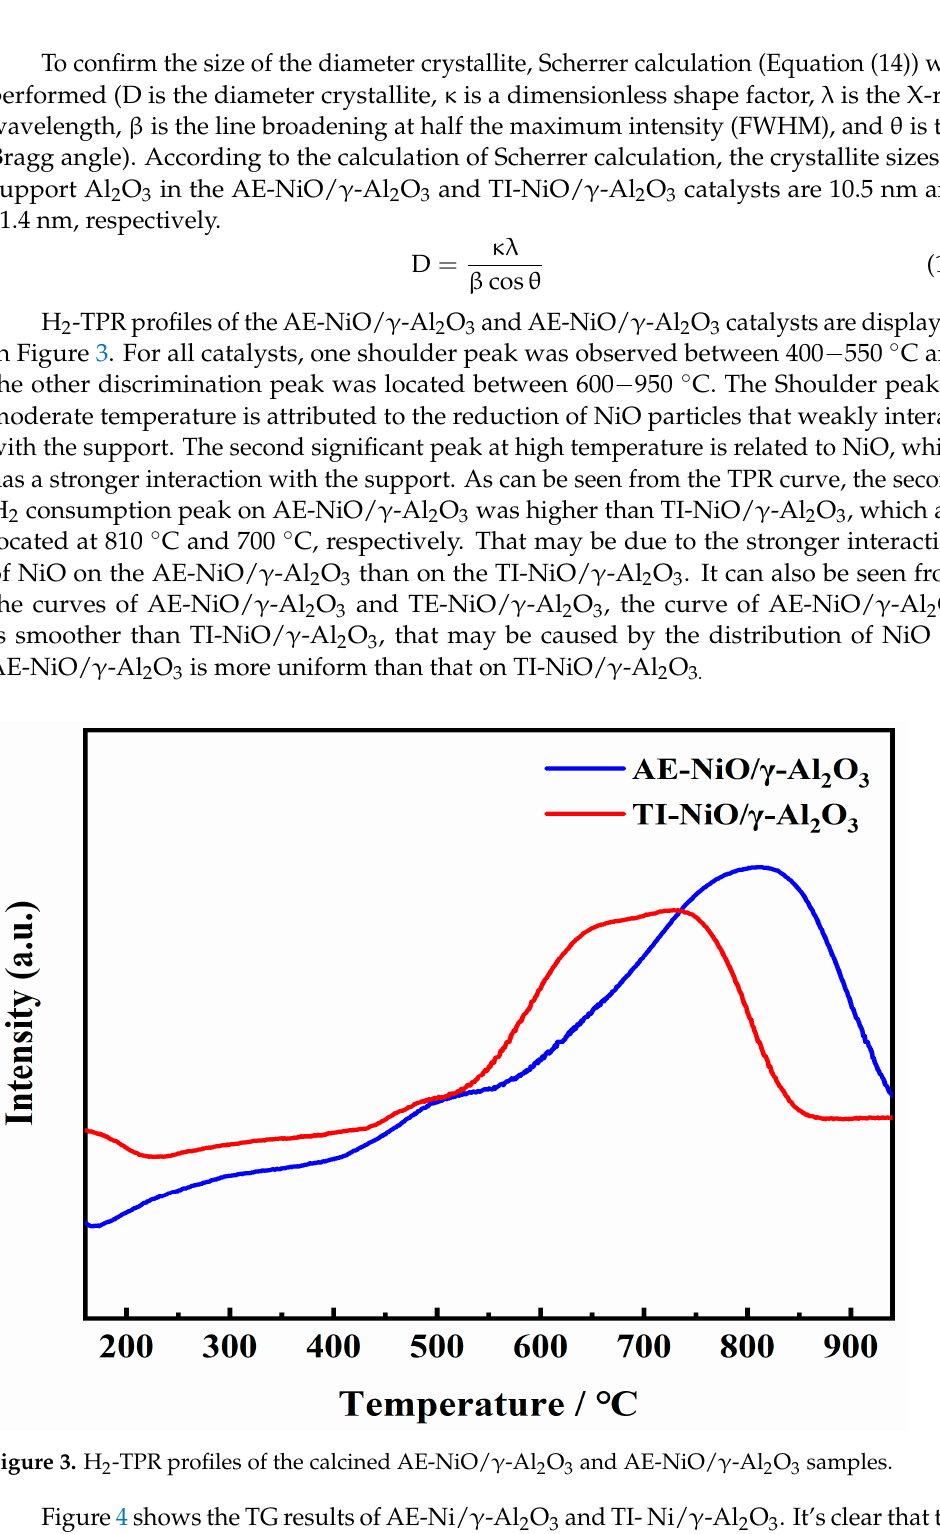
Figure 4. TG results of AE-NiO/ γ -Al 2 O 3 and TI-NiO/ γ -Al 2 O 3 . The TEM, HRTEM images and size distribution of AE-NiO/ γ -Al 2 O 3 catalyst are shown in Figure 5. The catalyst particles are highly dispersed in Figure 5b,c. As can be seen from the size distribution chart, the average particle diameter of NiO was 2.5 nm. When analyzing the exposed crystal plane, it was found that the crystal plane spacing of the exposed particles was 0.203 nm, which was consistent with the NiO (200) crystal